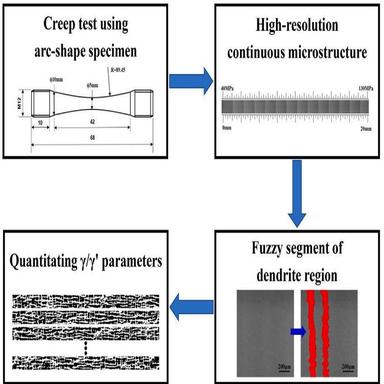
Workflow of microstructure characterization for nickel-based SX superalloys.